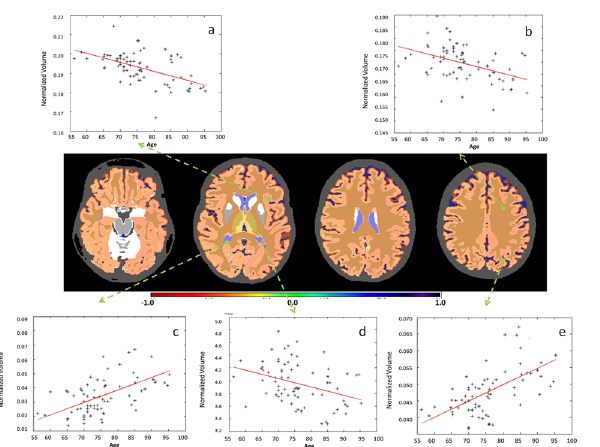
Fig 6. Examples of significant correlations between regional volumes and age at granularity level 2. The colors code the correlation coefficient R in regions where the age vs. volume curve achieves significance (p-value < 0.05, Bonferroni-corrected). Yellow / orange / red (R < 0) are regions that shrink over time, while blue (R > 0) are regions that expand over time, such as ventricles. As is shown in the figure: a. cerebral cortex (left); b. white matter (left); c. ventricle; d. thalamus (left); e. sulcus (left).